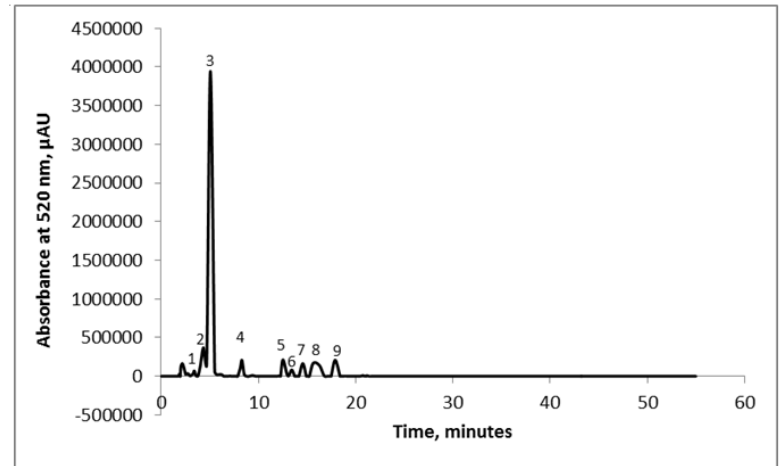
Figure 1. Chromatographic profile of the cornelian cherries’ extract: Peak 1—delphinidin-3-galactoside; Peak 2—cyanidin-3-glucoside; Peak 3—cyanidin-3-rutinoside; Peak 4—pelargonidin-3-glucoside; Peak 5—pelargonidin-3-rutinoside; and Peaks 6–9—unidentified compounds. The corresponding five compounds identified were: delphinidin-3-galactoside (1.03%),